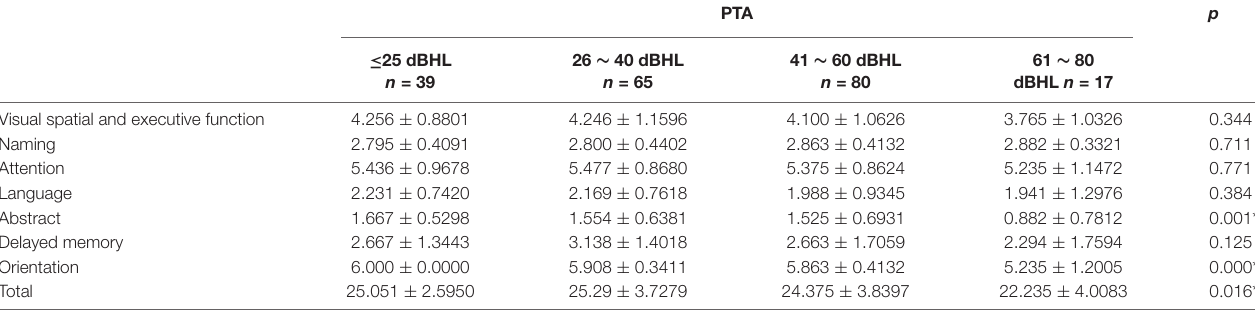
TABLE 2 | Correlation between PTA and different cognitive domains among the elderly.